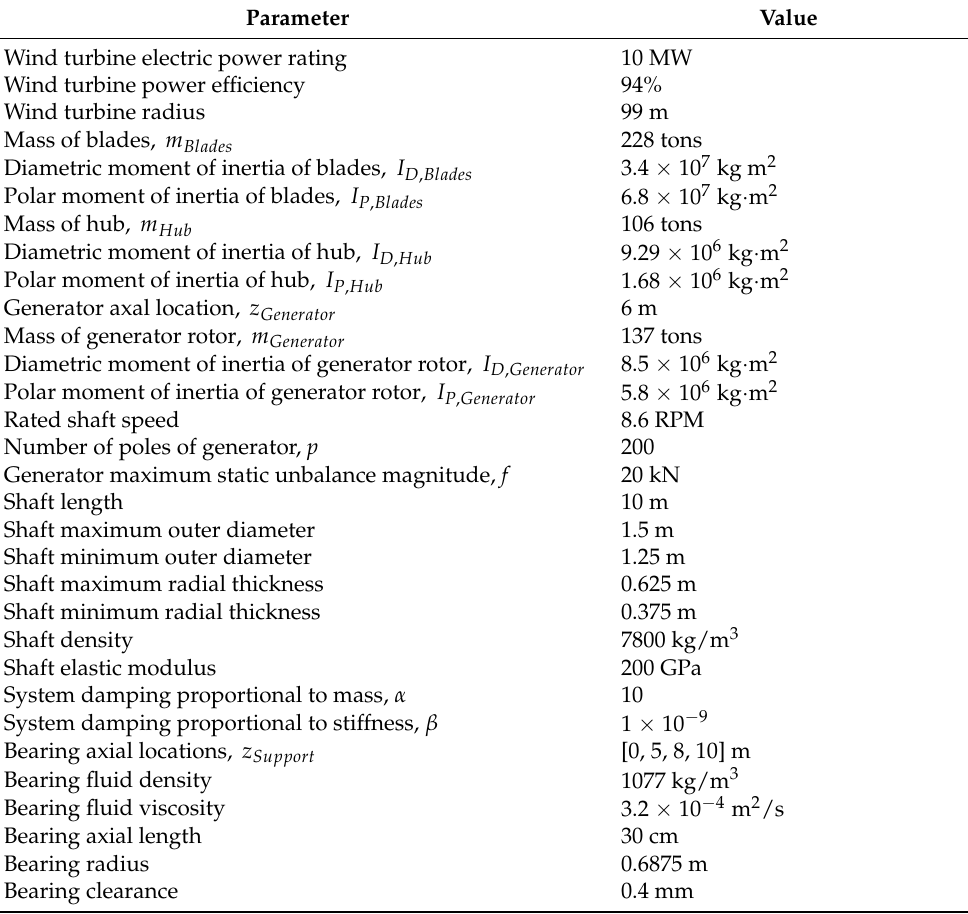
Table 1. 10 MW direct drive wind turbine parameters. These parameters are based on